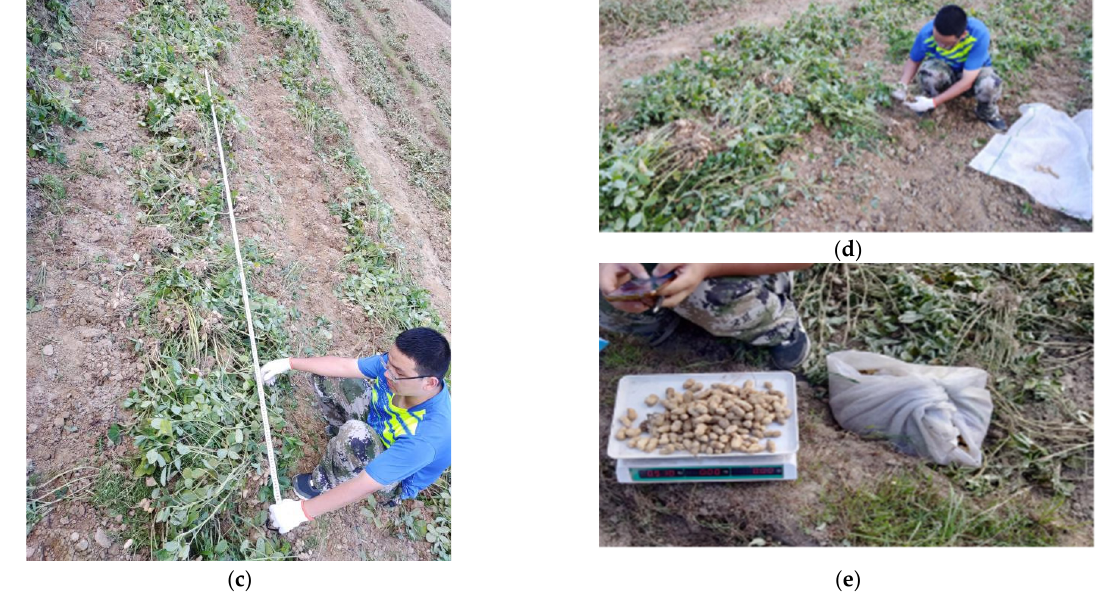
Figure 4. Field experiment flow of peanut digger-inverter: ( a ) The process of field experiment of peanut digger-inverter. ( b ) The effect of peanut digger-inverter after field operation. ( c ) Random 3 m sampling of a stroke after peanut operation. ( d ) The sampled peanuts were picked manually. ( e ) The buried pod, fallen pod, and total pod weight of peanuts shall be weighed after operation.